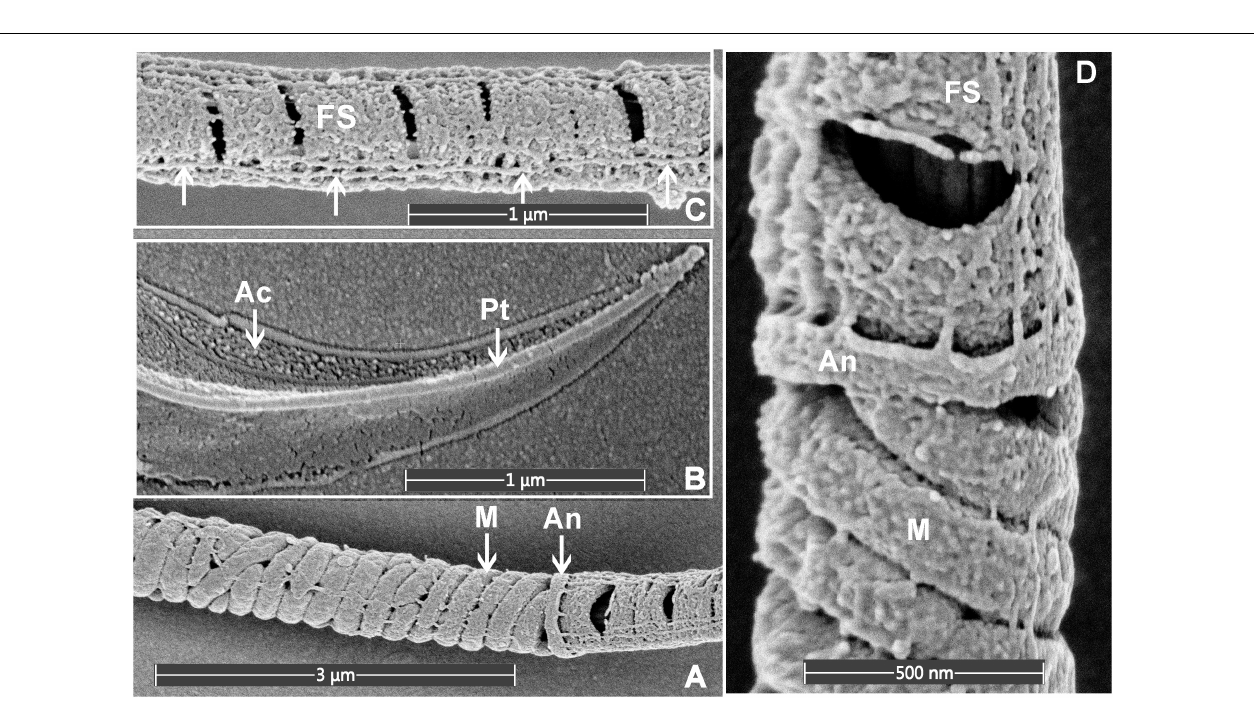
FIGURE 3 | Scanning electron microscopy images of mouse sperm fixed using 3.5% glutaraldehyde in PBS without post-fixation. (A) The helically arranged mitochondria (M) within the mid-piece and the annulus (An) which prescribed the junction between the mid- and principal pieces of the sperm tail. (B) The apical tip of the sperm head, revealing the acrosome (Ac) and perinuclear theca (Pt). (C) The principal piece of the sperm tail revealing the circumferentially arranged ribs of the FS and longitudinal structures running along the length of the principal piece (marked with the arrows). (D) A higher power image of the junction between the mid- and principal piece junction of a sperm